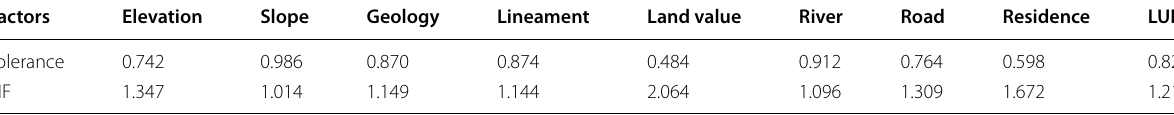
Source: Computed by the author Table 4 Saaty’s relative importance scale value